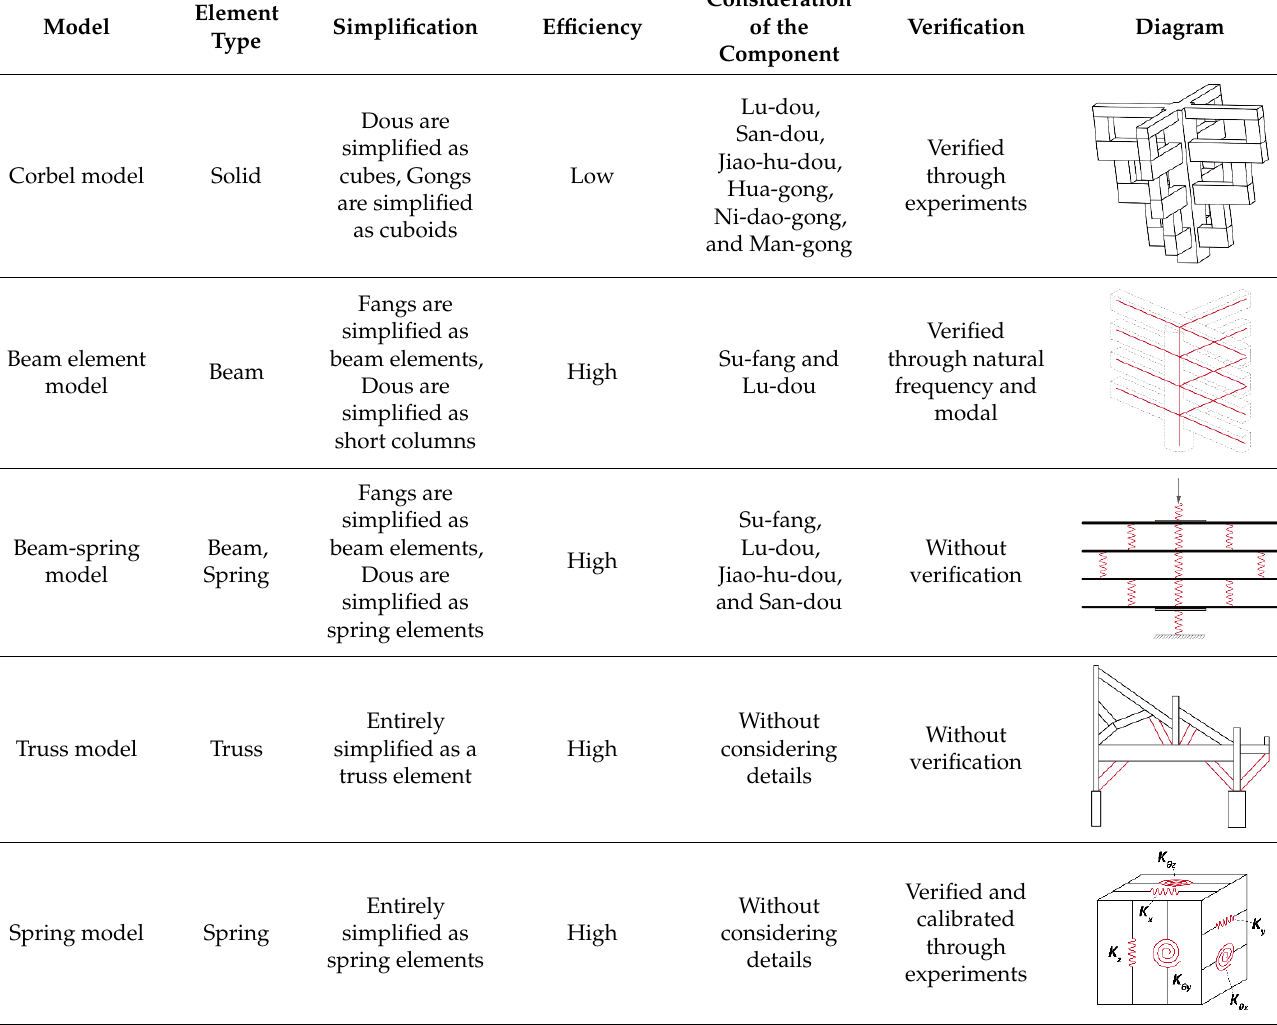
Table 3. Typical simplified Dou-gong models in recent literature